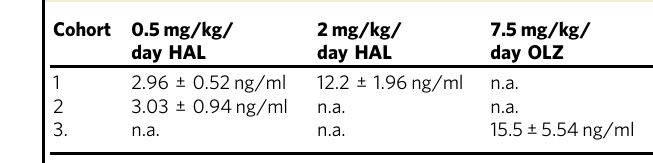
Table 3 Plasma levels of haloperidol (HAL) and olanzapine (OLZ) in treated